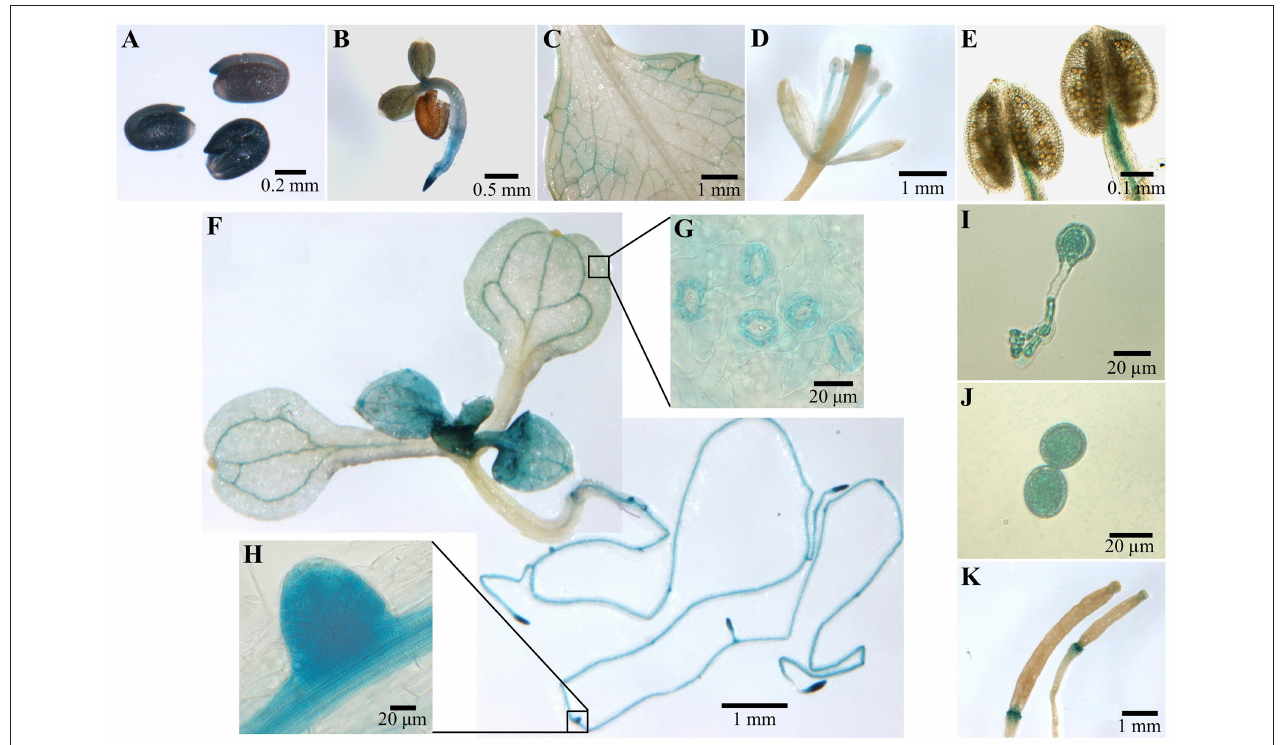
FIGURE 4 | COX11:GUS promoter analysis. Plants from three COX11:GUS lines (T2 generation) were assayed for GUS activity at various developmental stages by bright-field microscopy. Representative staining patterns are shown. (A) Embryos after overnight imbibition and removal of the seed coats. (B) A 3-day-old seedling. (C) Mature leaf. (D) Arabidopsis flower. (E) Anthers with mature pollen. (F) Two images of different parts of a 12-day-old seedling, stitched together. The insert panels show a section of its cotyledon (G) and a lateral root primordium (H) at a higher magnification. (I) Germinated pollen. (J) Pollen grain rehydrated in 18% sucrose. (K) Siliques at different developmental